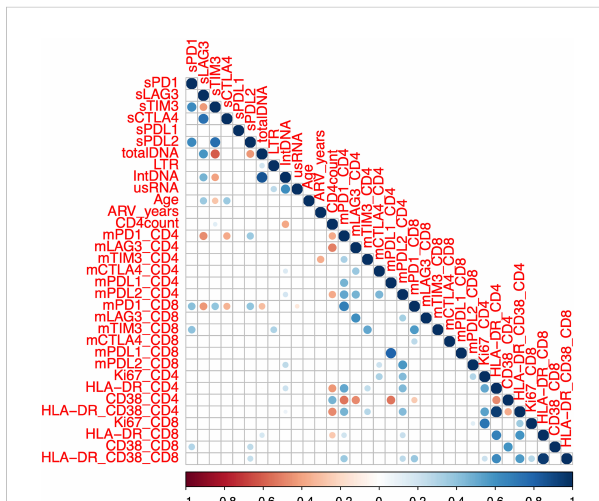
FIGURE 2 Correlation between soluble and membrane bound immune checkpoint proteins and clinical and laboratory markers in participants on antiretroviral therapy. Soluble (s) immune checkpoint proteins, reservoir size and clinical markers (n=75, SCOPE (n=48) and DIORR (n=27)), as well as membrane bound (m) immune checkpoint proteins and markers of immune activation (n = 48, SCOPE) were quanti fi ed in participants on antiretroviral therapy. Dots represent statistical signi fi cance of a given Spearman correlation with p < 0.05, and colour gradient indicates the coef fi cient and the directionality of the correlation. Unspliced HIV RNA (usRNA), HIV integrated DNA (intDNA), 2 LTR circles (LTR), antiretroviral duration (ARV), soluble (s) or membrane bound (m) Programmed Cell Death protein 1 (PD-1), Lymphocyte Activation Gene-3 (LAG-3), T cell Immunoglobulin domain and Mucin domain 3 (TIM-3), Cytotoxic T-Lymphocyte-Associated protein 4 (CTLA-4), PD-1 Ligand 1 (PD-L1) and PD-1 Ligand 2 (PD-L2).